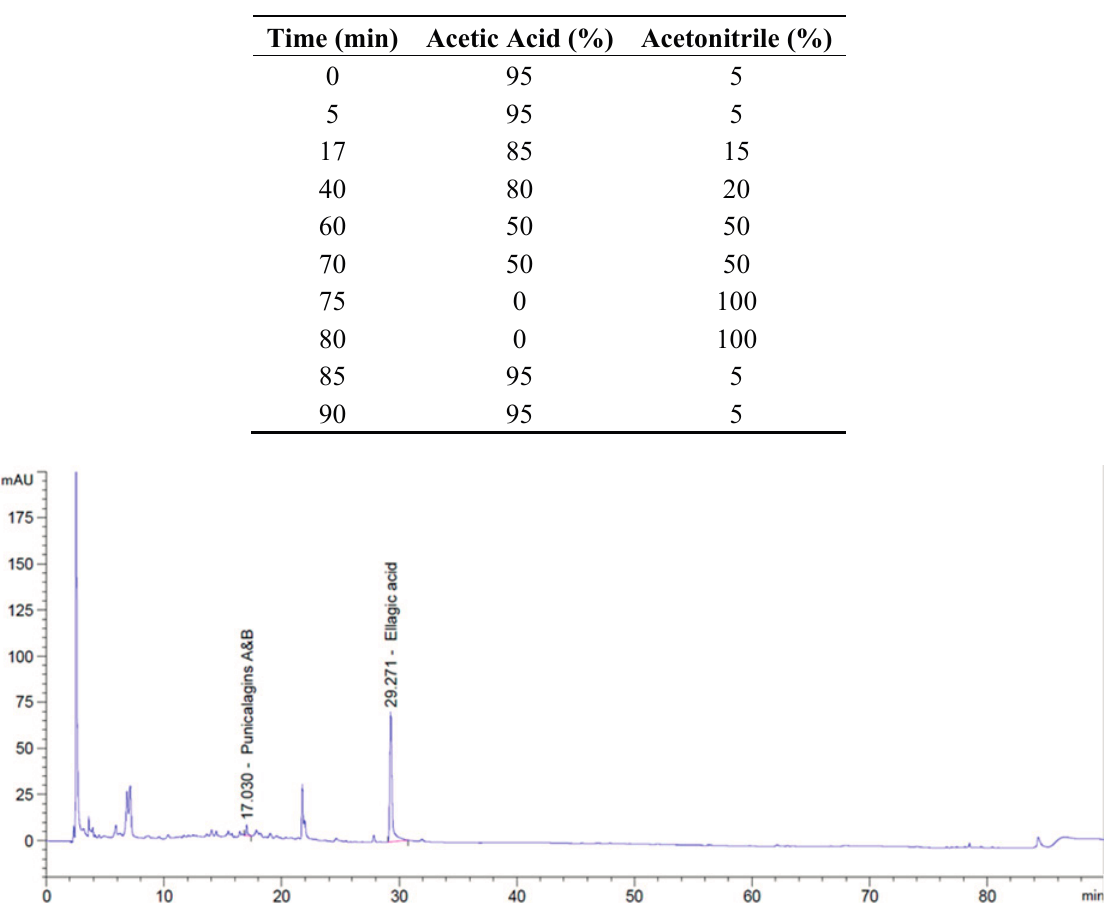
Table 2. HPLC column elution gradient for pomegranate concentrate powder.